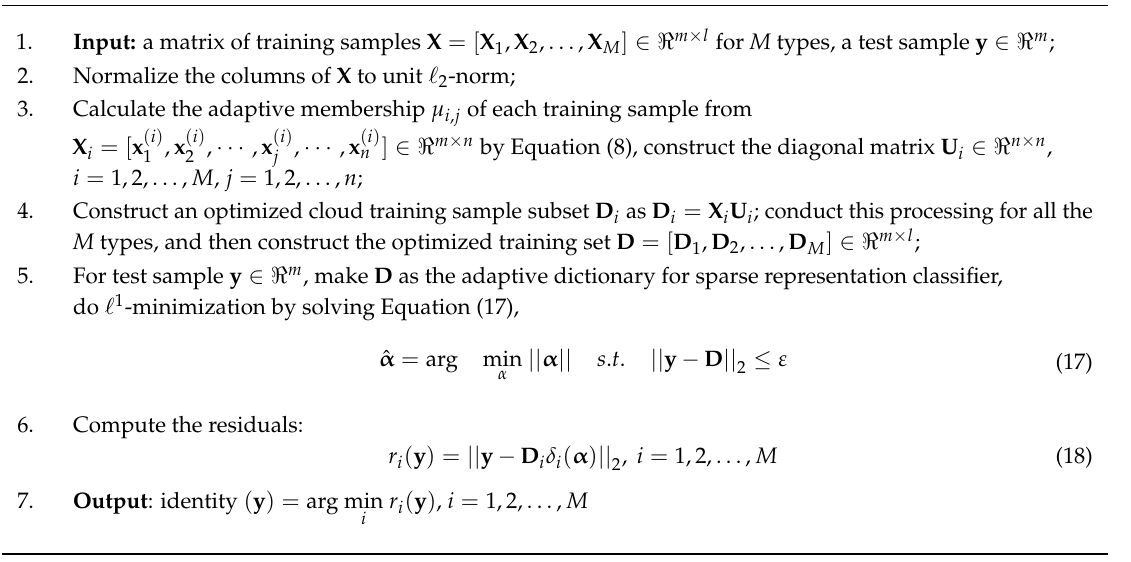
Algorithm 1 : Classification of clouds in satellite imagery using adaptive fuzzy sparse